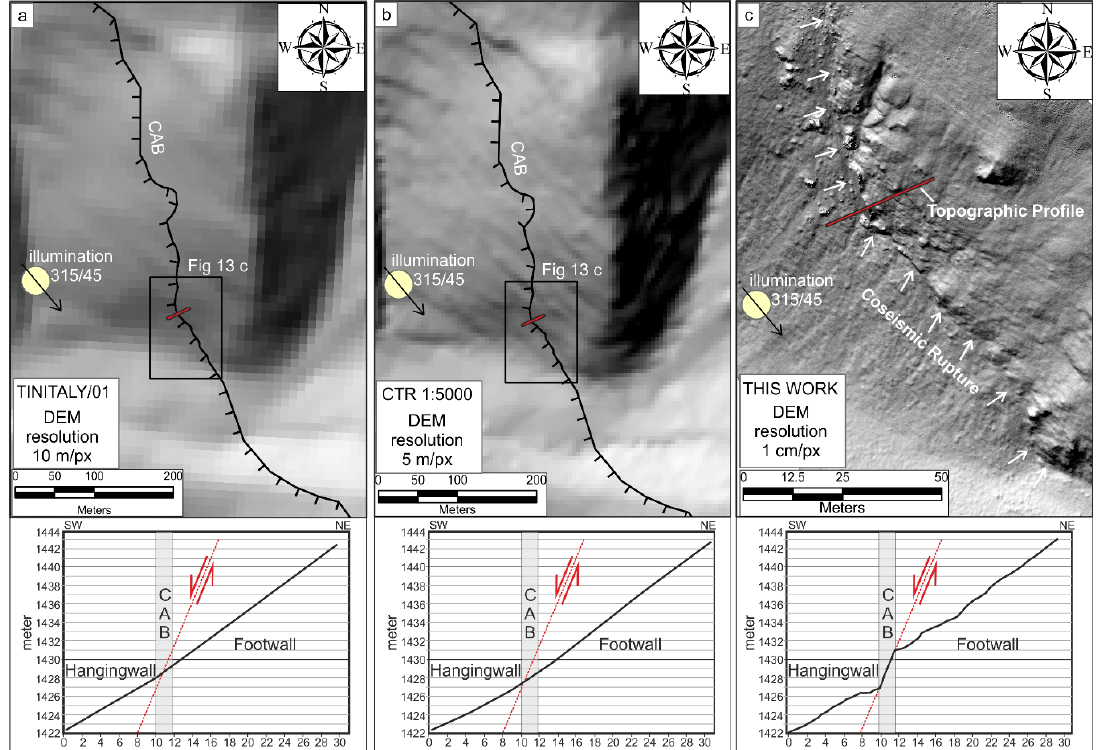
Figure 13. Comparison of DEM and detailed topographic profile obtained from: ( a ) TINITALY/01 http://tinitaly.pi.ingv.it/ [95] with a resolution of 10 m per pixel; ( b ) Cartografia Tecnica Regionale vectorial 1:5000 scale from Regione Umbria [http://www.umbriageo.regione.umbria.it/pagina/distribuzione-carta-tecnica-regionale-vettoriale-1- 000], with a resolution of 5 m per pixel; ( c ) 1 cm per pixel obtained from this work.